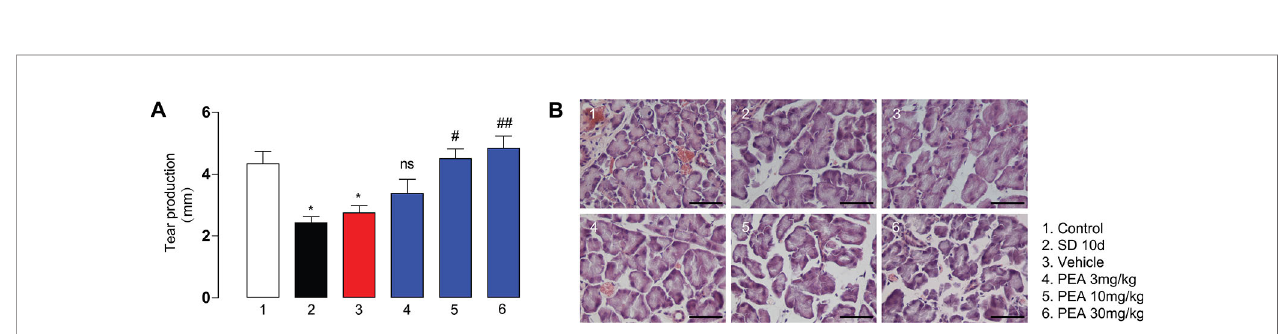
FIGURE 2 | PEA treatment in SD-induced mice dose-dependently increased tear secretion (A) and reduced LG acini size (B) . *, P < 0.05 vs. control group (1); ## , P < 0.01; ### , P < 0.001 vs. vehicle group (3), n =